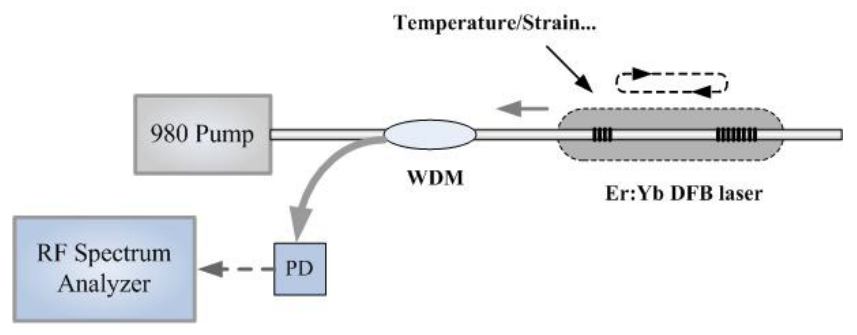
Figure 1. The diagram of the dual polarization DBR fiber laser based fiber